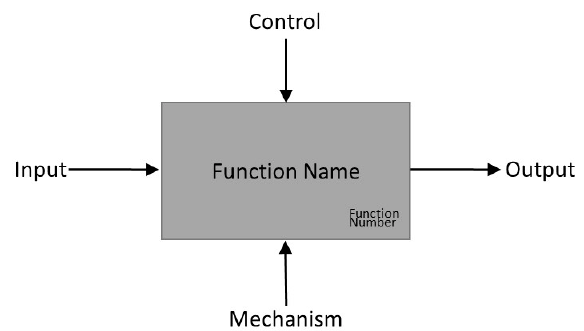
Figure 3. Integration definition for function modeling (IDEF0) shows the inputs, control, outputs, and mechanisms of